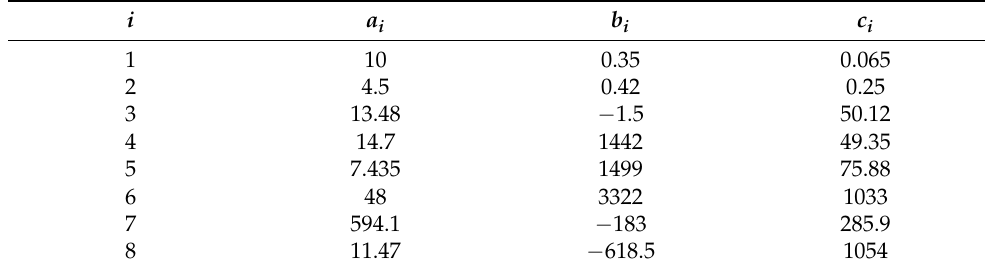
Table 1. The a i , b i , and c i parameter